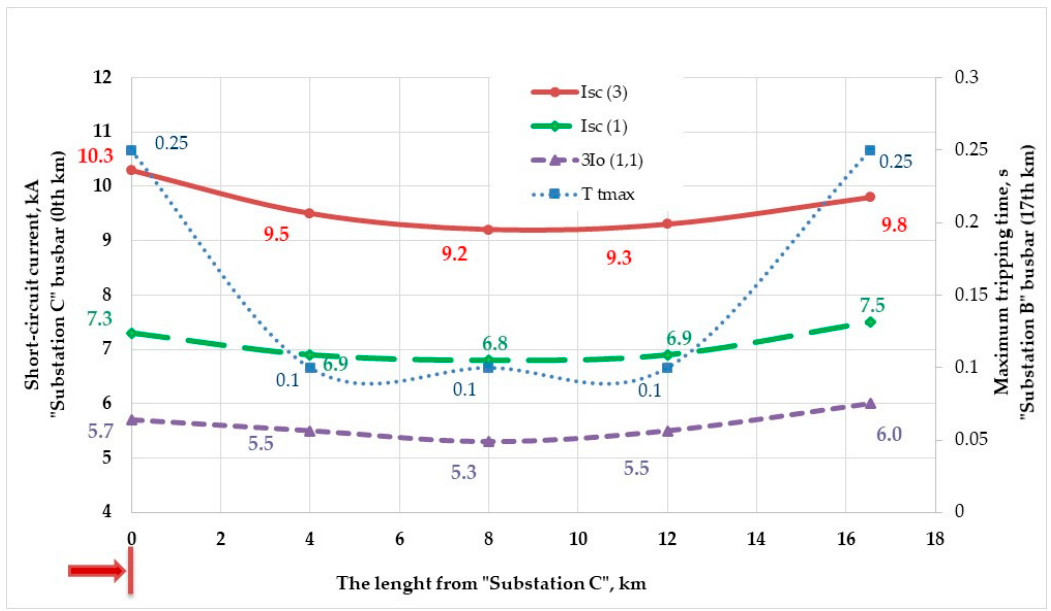
Figure 4. Estimated short-circuit currents along 110 kV “OHL No.2” from “Substation C” (zeroth km) toward “Substation B” (17th km).